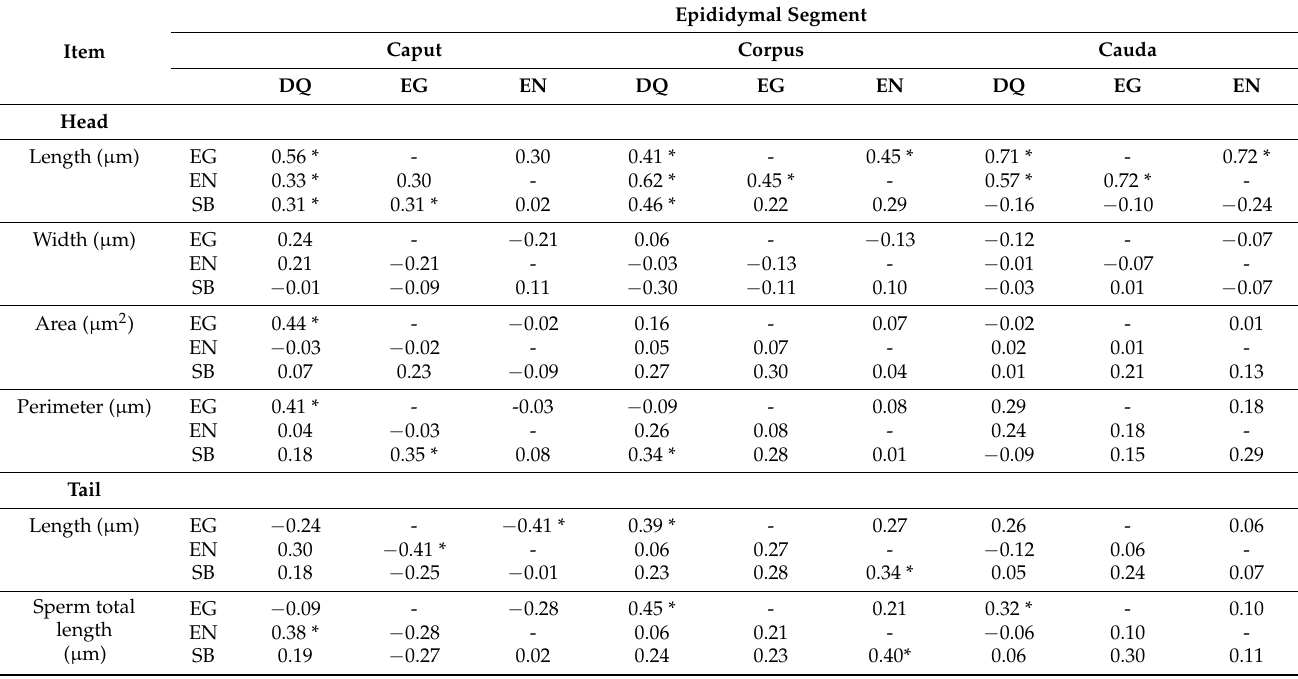
Figure 1. Morphometric dimensions of the heads of sperm collected from the caput, corpus and cauda of the epididymides depending on the staining method (EG, EN, DG, SB). Bars represent means ± SEM (number of analyzed cells = 2400). Table 3. Pearson correlation coefficients between the morphometry of sperm collected from the caput, corpus and cauda of the epididymis of dogs and the staining method (DQ—DiffQuik, EG—eosin-gentian, EN—eosin-nigrosin and SB— SpermBlue) (* p <